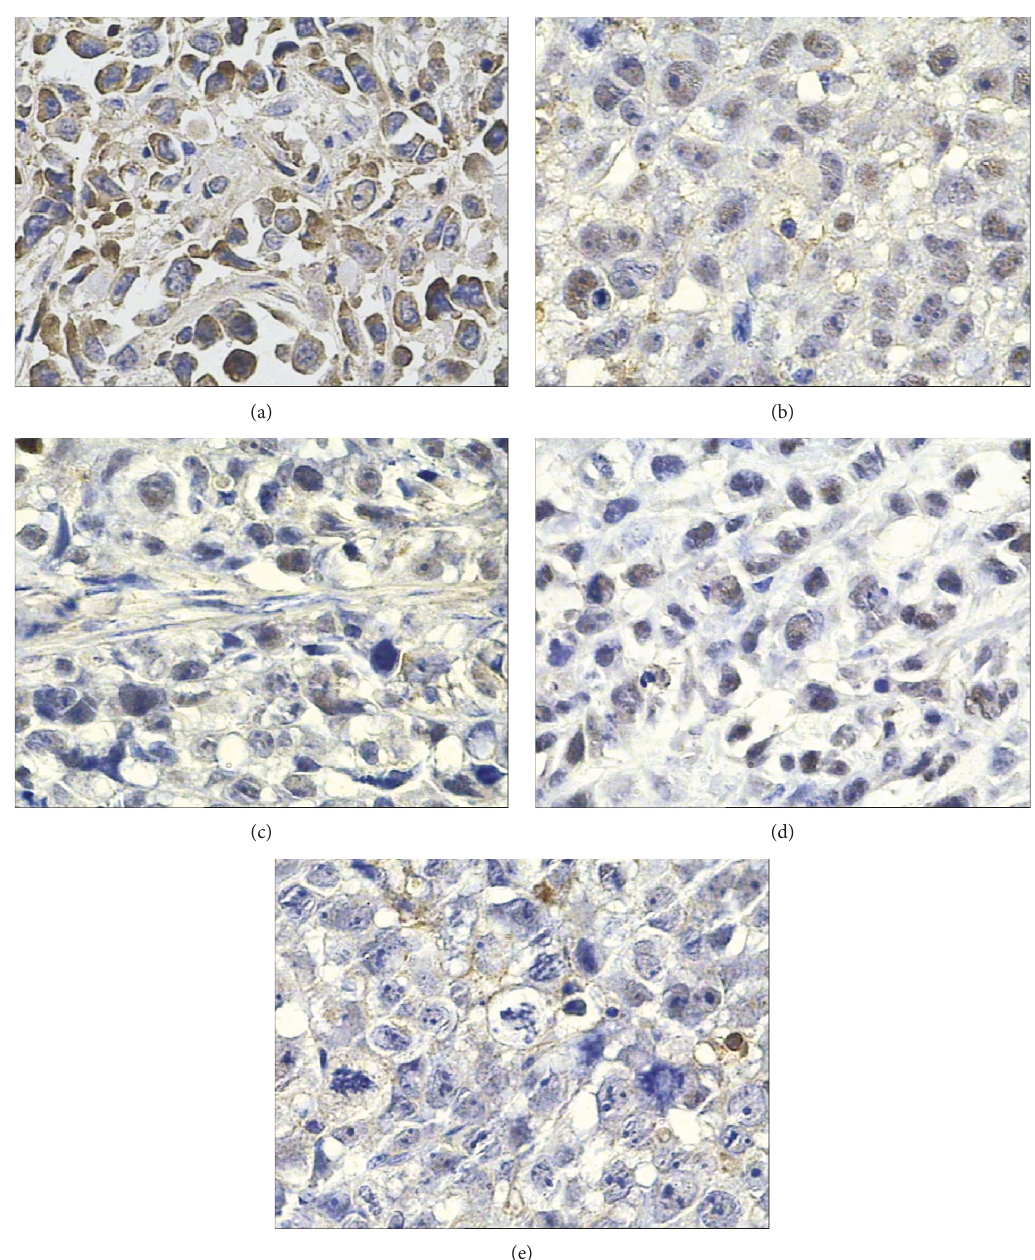
Figure 5: p53 protein expression in hepatoma tissues after di ff erent treatments tested by IHC (400x). (a) Saline control group. (b) Radionuclide group. (c) Radionuclide-gene group. (d) MFH group. (e) Radionuclide-gene-MFH